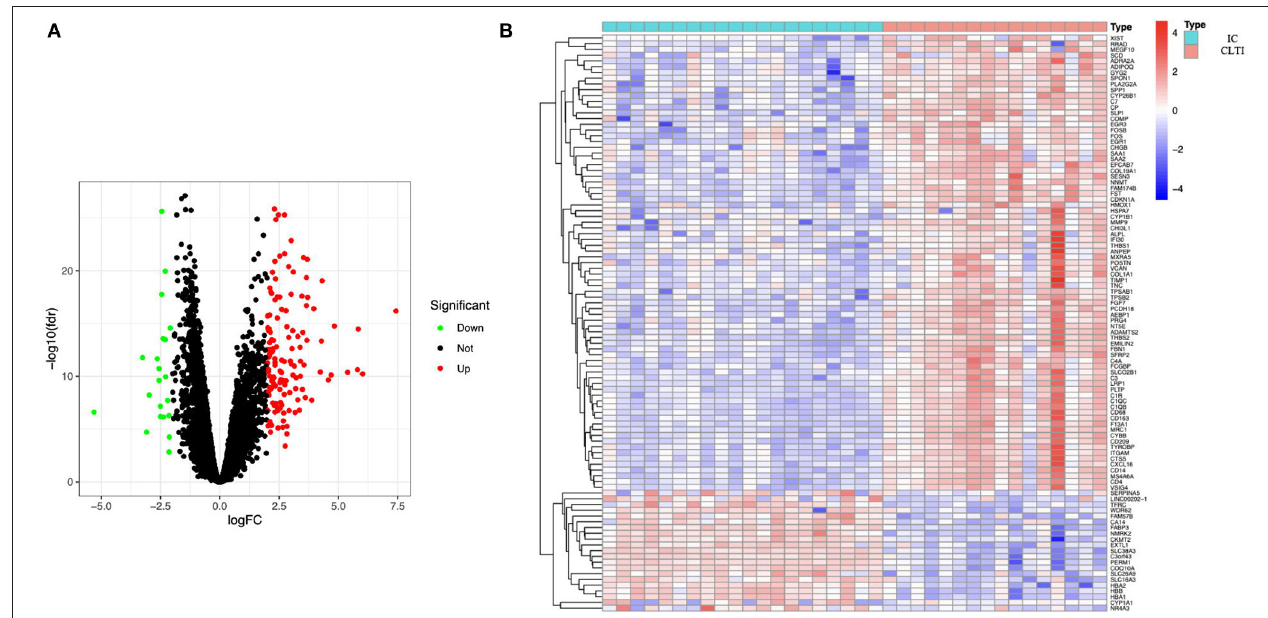
FIGURE 1 | Samples from patients with IC and CLTI have different gene expression profiles. (A) Volcano plot revealed 137 upregulated intersecting genes and 21 downregulated genes between the IC and CLTI groups. (B) Heatmap of the top 50 upregulated genes and all the downregulated genes in GSE120642. IC, intermittent claudication; CLTI, chronic limb-threatening